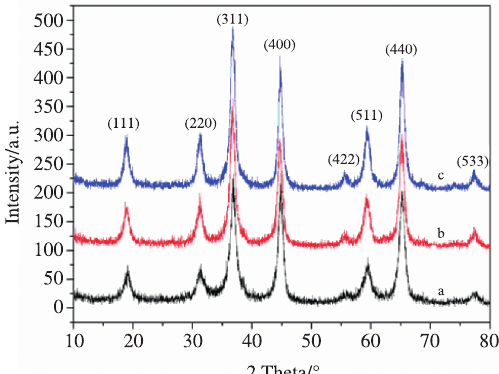
Figure 3. XRD patterns of the precursor synthesized from forward- titration process and powders calcined at different temperatures for 2h (a. as-prepared; b. 500 °C; c. 600 °C; d. 700 °C; e. 800 °C; f. 900 °C; g. 1000 °C).